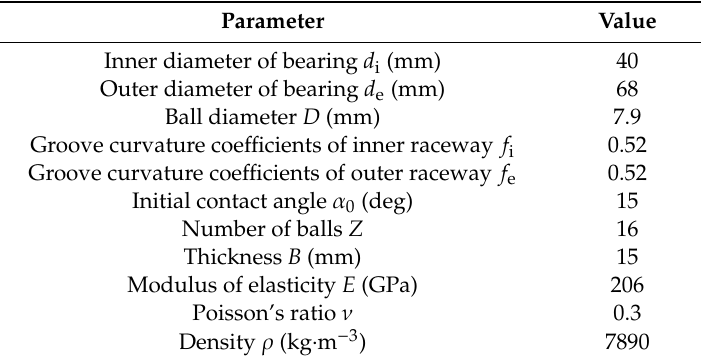
Figure 10. Shaft-bearing system with three angular contact ball bearings. Table 2. The parameters of angular contact ball bearing 7008C.